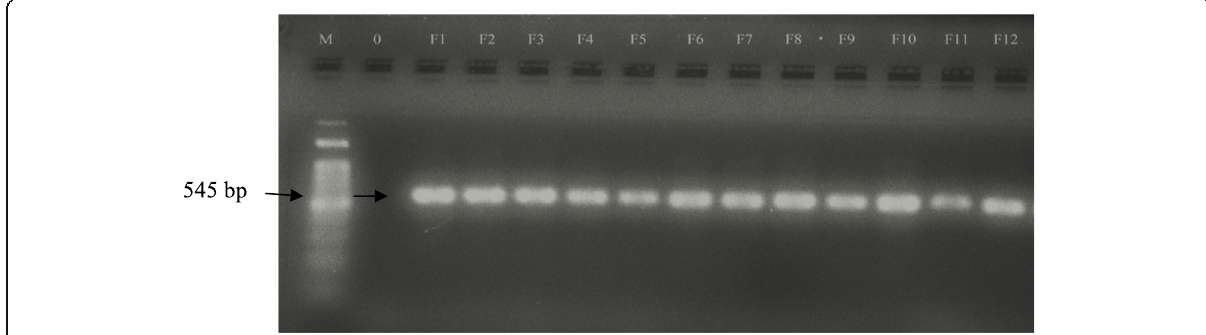
Fig. 3 PCR products amplified using ITS primers (ITS1 and ITS4) from twelve potential isolates of Metarhizium anisopliae . M, 1000 bp ladder; 0,